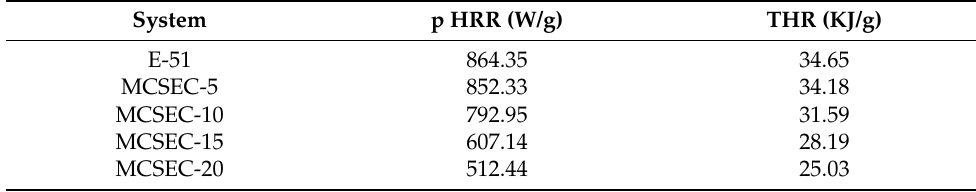
Table 2. Relevant parameters of different systems measured by a cone